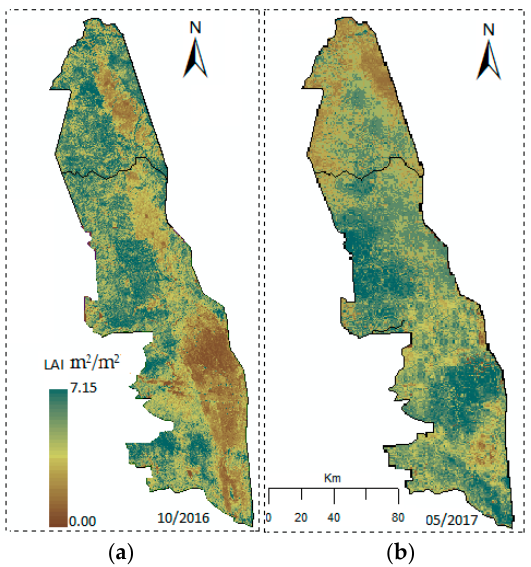
Figure 7. Distribution of LAI in Kruger national park during the ( a ) dry and ( b ) wet seasons.